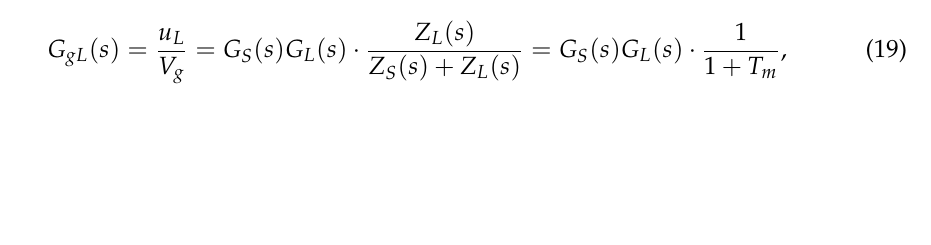
V g Source sub-system